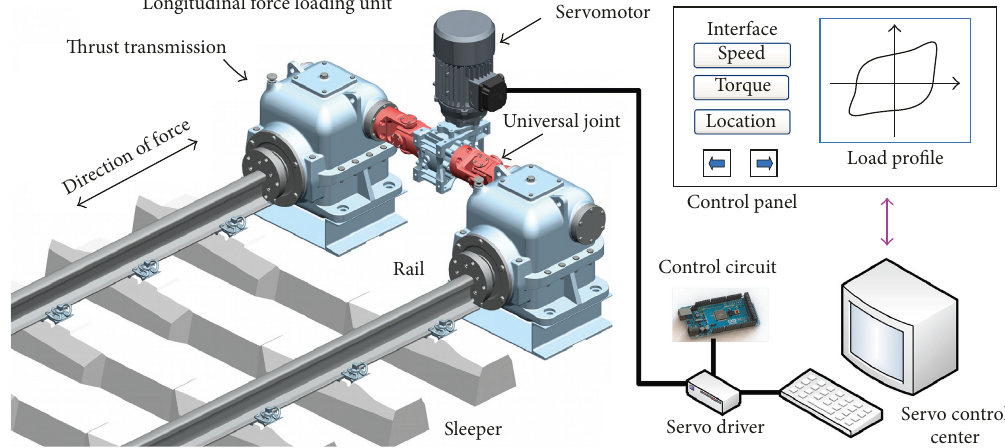
Figure 3: Schematic diagram of the loading apparatus.